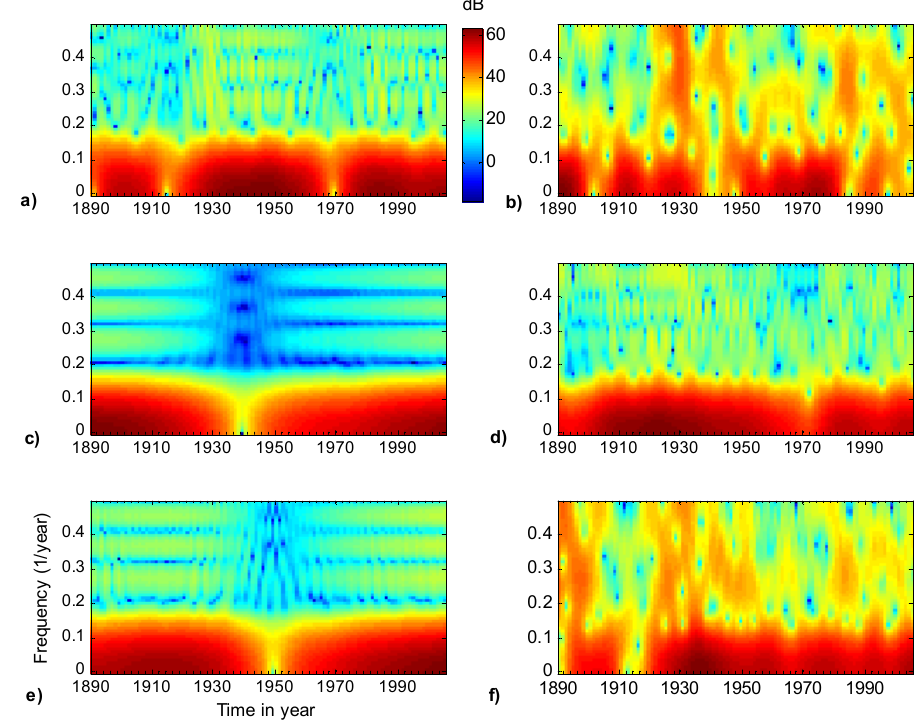
Fig. 3. Spectrograms of annual means of the geomagnetic field components and their secular variation (first differences) for NGK observatory (1890–2005): (a) X component, (b) X secular variation, (c) Y component, (d) Y secular variation, (e) Z component, (f) Z secular variation.